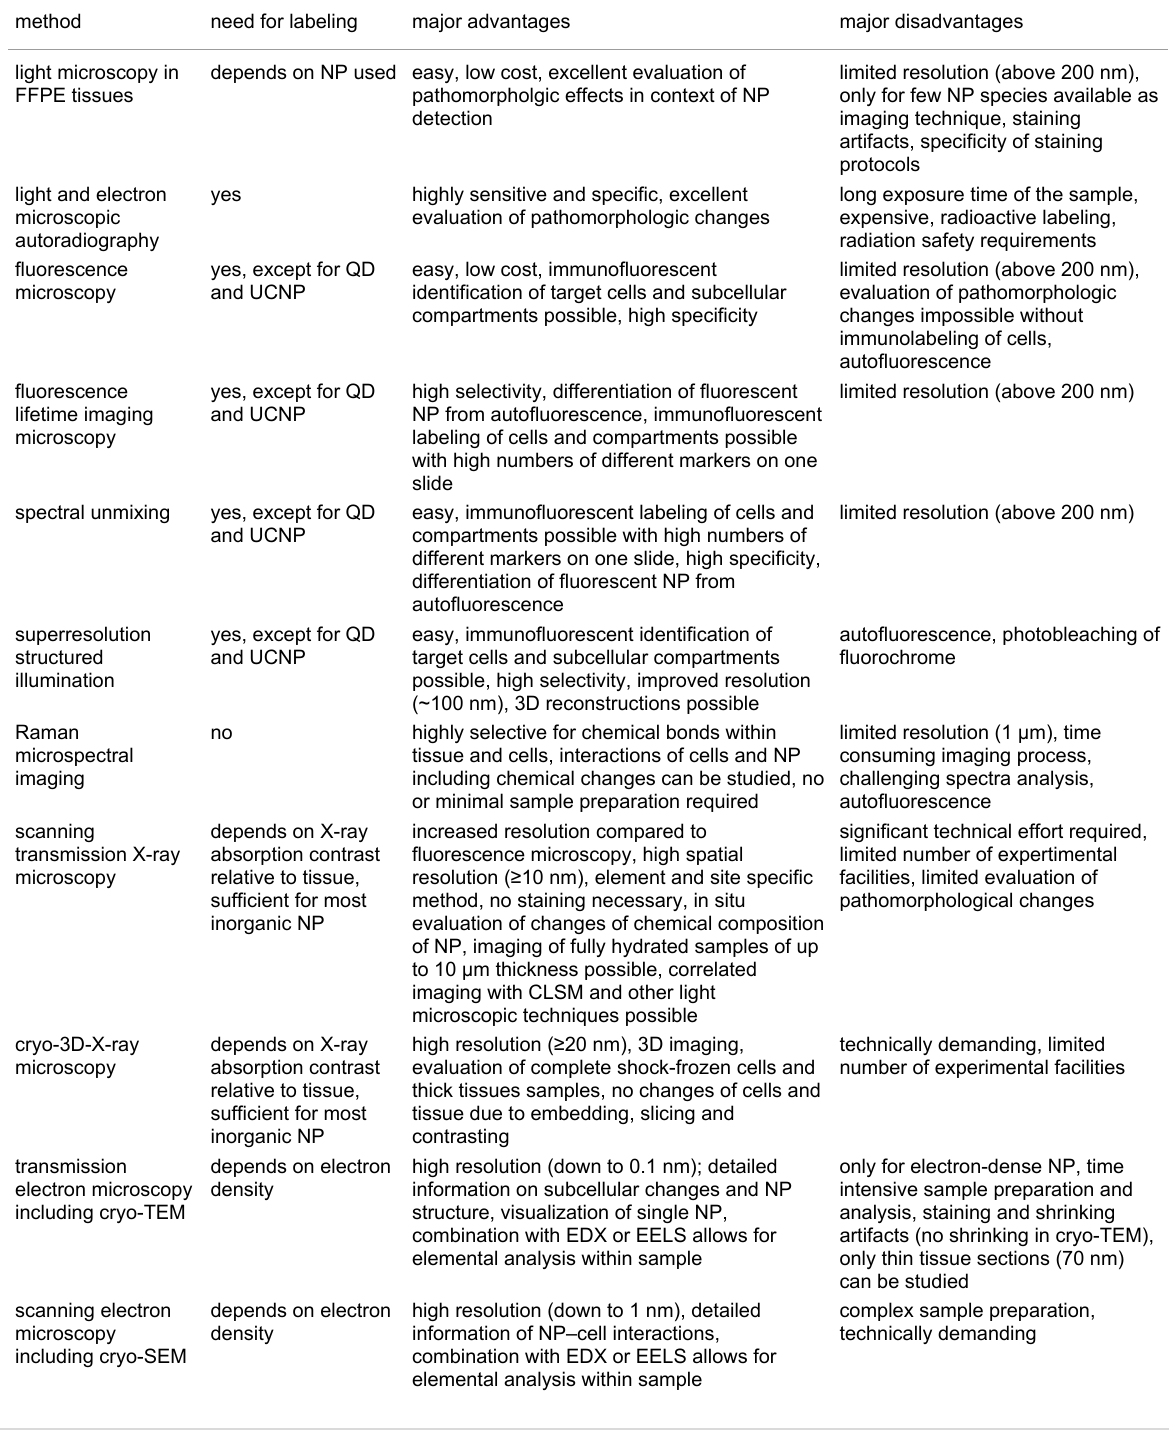
Table 1: Comparison of analytical methods for the visualization of nanoparticles in the context of adjacent